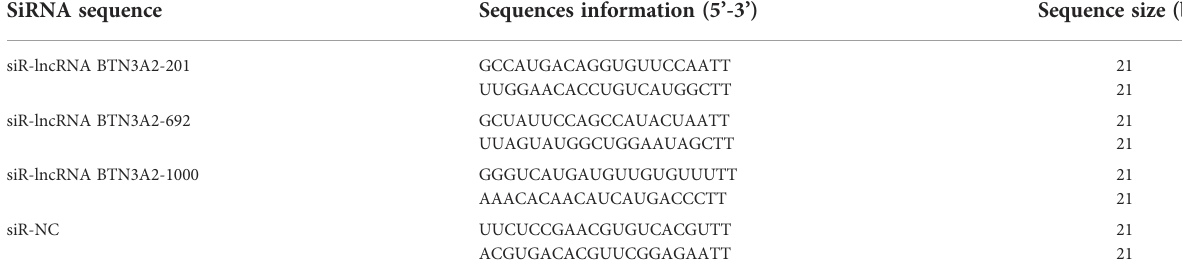
TABLE 1 lncRNA BTN3A2 siRNA sequences and negative control sequence information. SiRNA